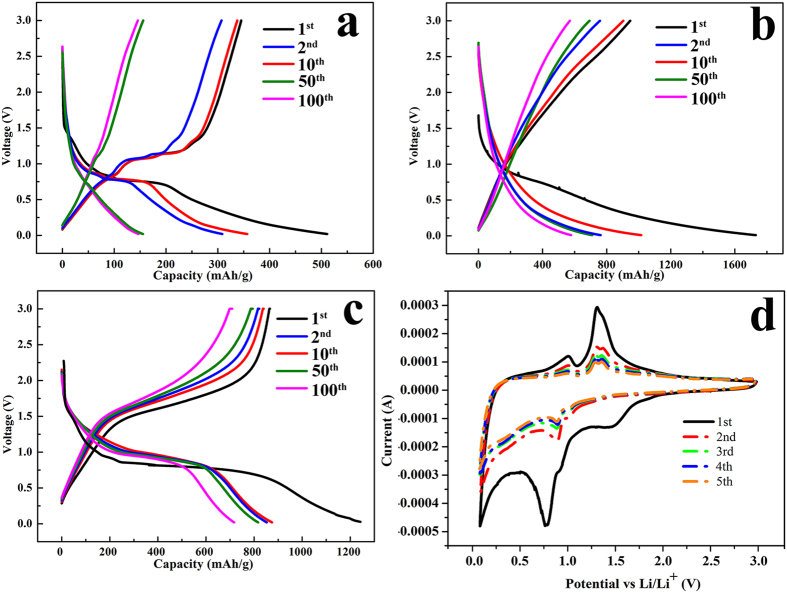
The 1st, 2nd, 10th, 50th, 100th charge/discharge curves of (a) Cu3P, (b) RGO and (c) Cu3P/RGO nanocomposite at a current density of 500 mAg−1. (d) Cyclic voltammograms of Cu3P/RGO nanocomposite at a scanning rate of 0.2 mV/s.